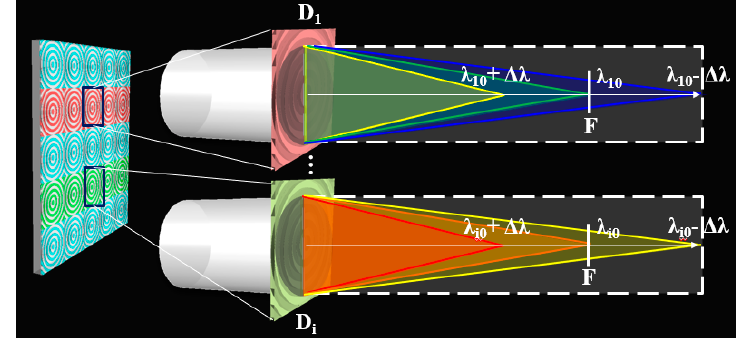
Figure 1. Multi-spectral imaging principle of artificial compound eye (ACE).